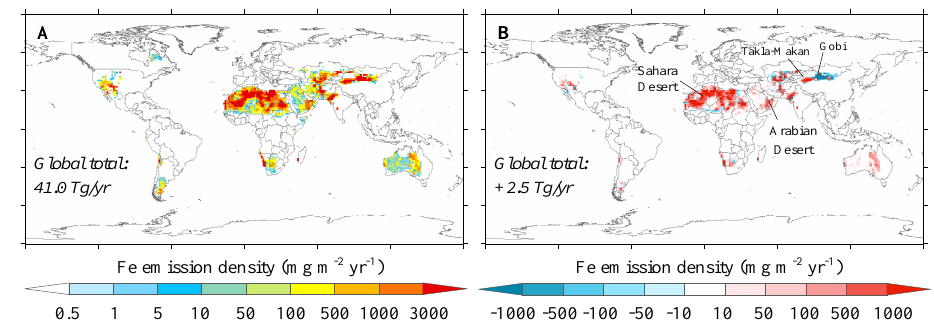
Figure 5. Average Fe emission from dust sources for 2000–2011 using the new mineralogical data set (a) and the difference of average Fe emission from dust sources for 2000–2011 using the new mineralogical data set relative to that using a constant Fe content (3.5%) (b) . A positive value in (b) indicates a larger emission density by using the new mineralogical data